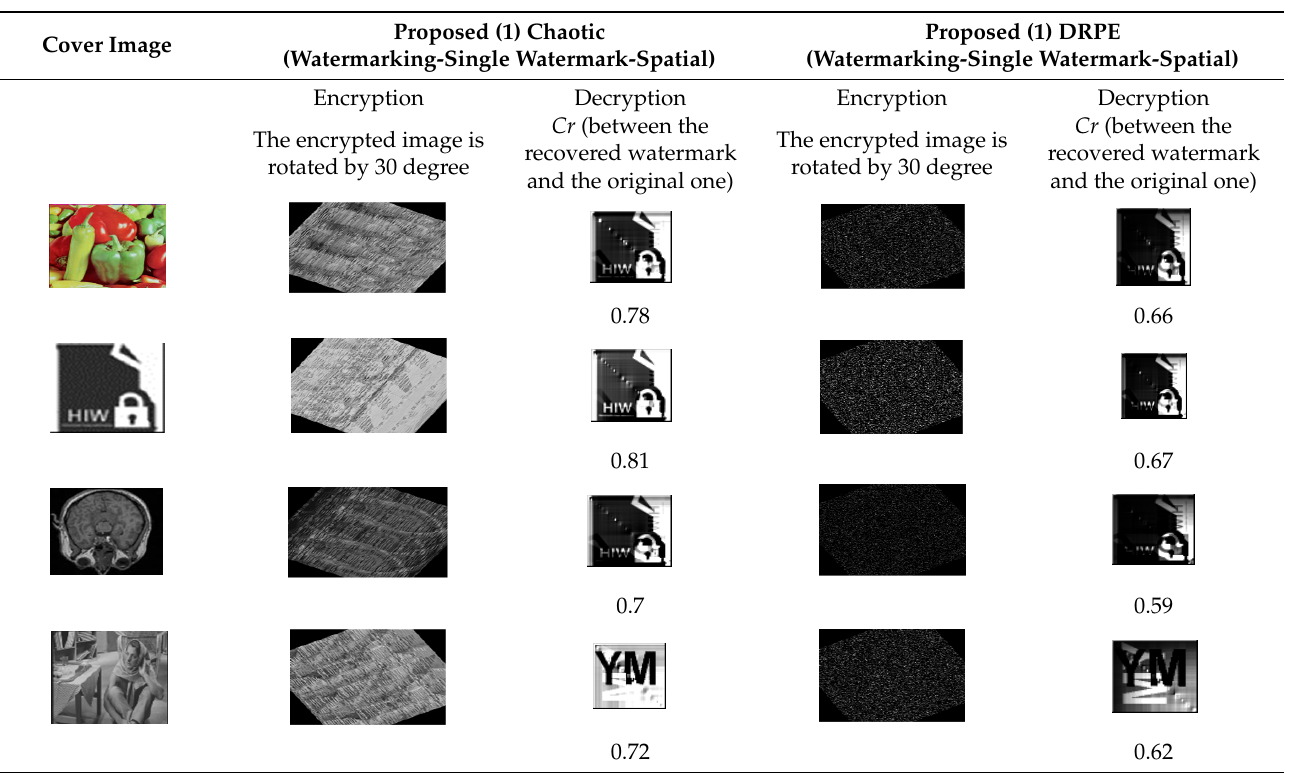
Table 10. Rotated images and corresponding extracted watermarks for the first proposed